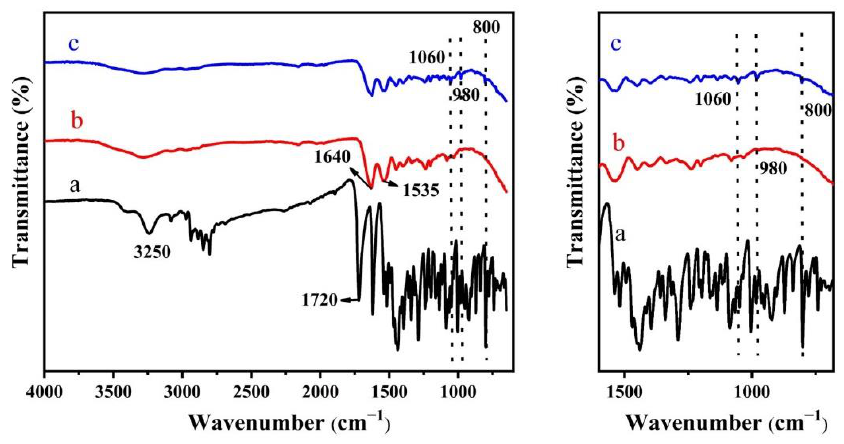
Figure 2. Infrared spectra of levofloxacin and different levofloxacin-containing gelatin fiber membranes: ( a ) levofloxacin drug, ( b ) crosslinked gelatin/genipin membrane, ( c ) crosslinked gelatin/genipin membrane with 5 wt% levofloxacin.